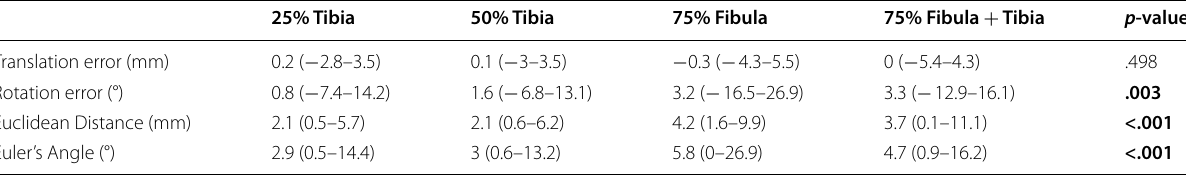
§ Values in median and ranges () ‡ Friedmann’s